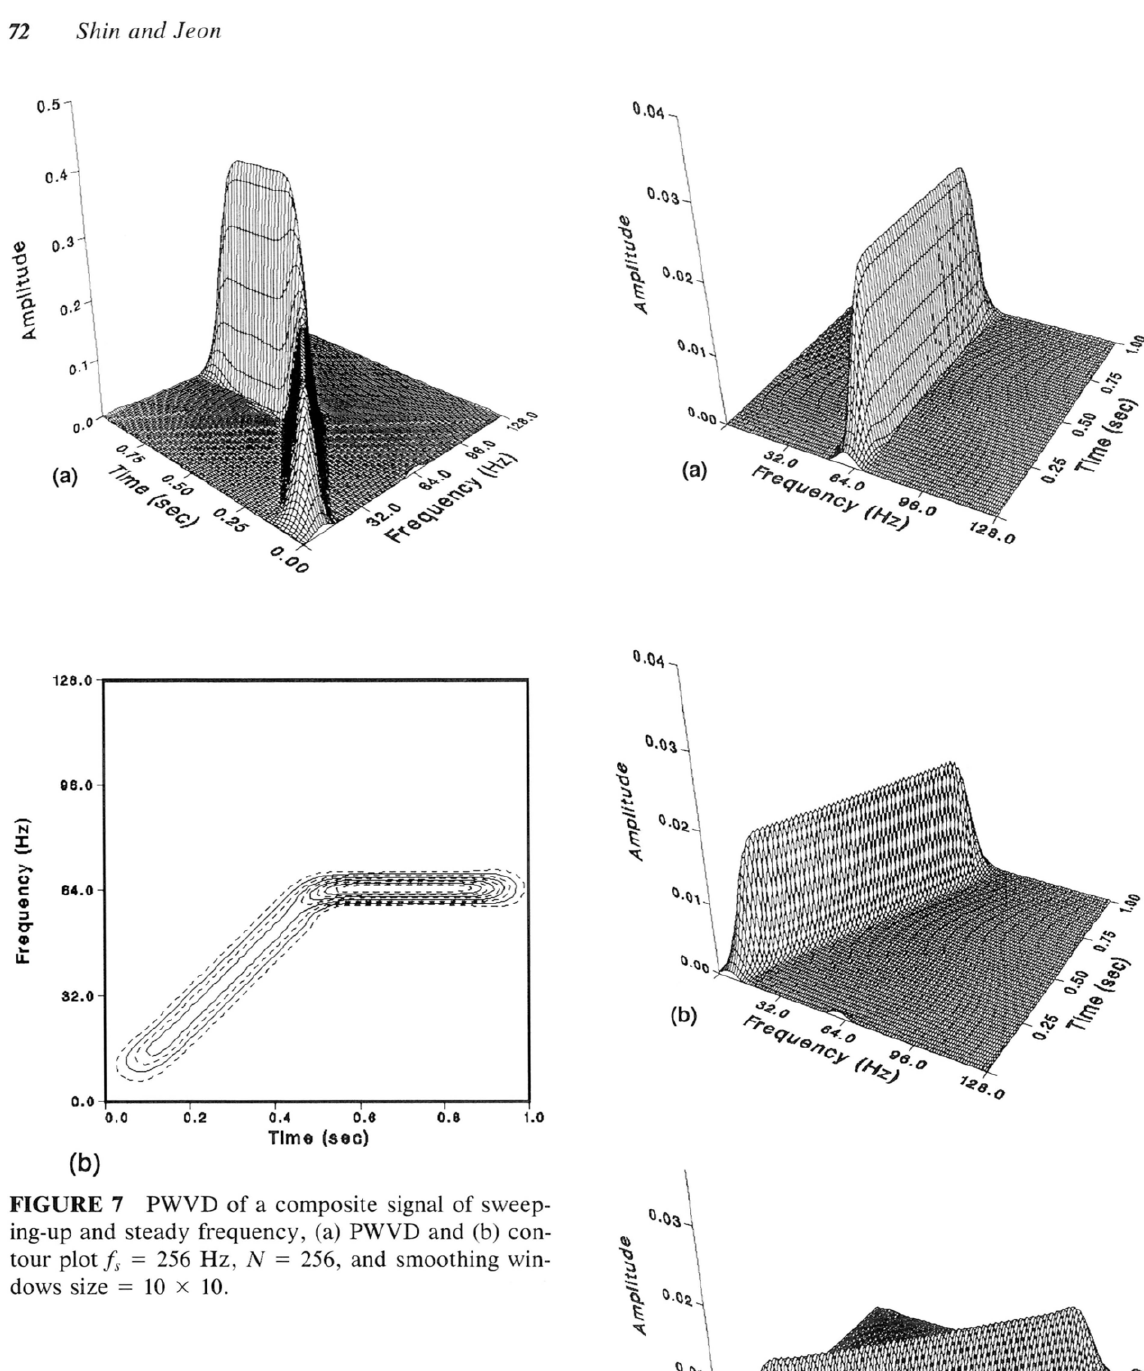
FIGURE 7 PWVD of a composite signal of sweep ing-up and steady frequency, (a) PWVD and (b) con tour plot is = 256 Hz, N = 256, and smoothing win dows size = 10 x 10.